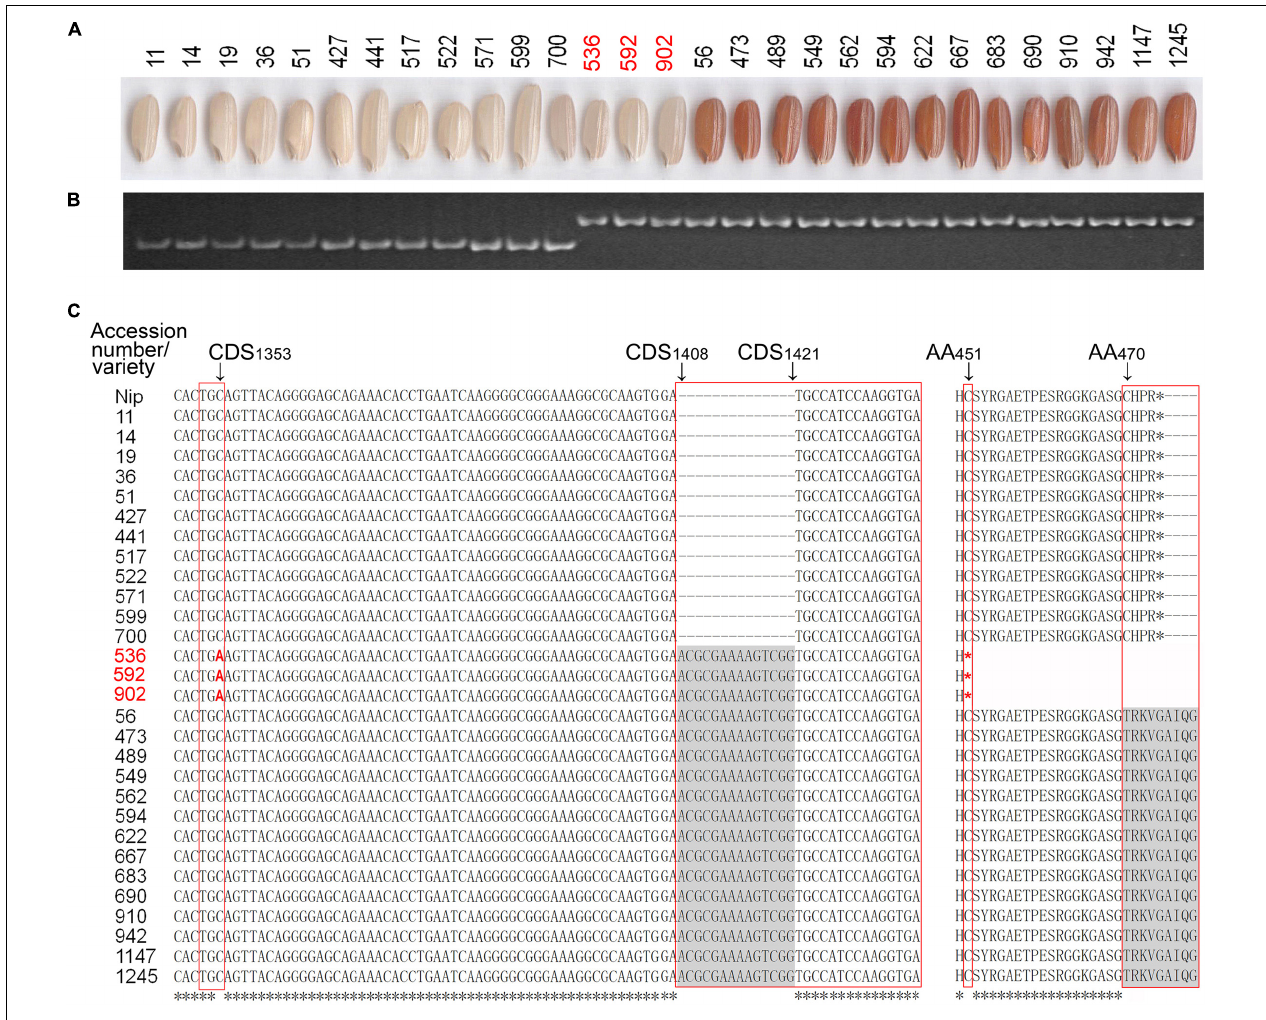
FIGURE 4 | Analysis of allelic variation in Rc gene. (A) Exhibition of PC in the rice accessions. (B) Three rice accessions (accessions 536, 592, and 902) with white pericarp exhibited the same polymorphism as those with red pericarp in polyacrylamide gel electrophoresis. (C) Variation in the CDS region of the three and other rice accessions. The three rice accessions (accessions 536, 592, and 902) are highlighted in red fonts and the various regions are framed in red. Nip, Nippobare ; CDS, coding sequence; AA, amino